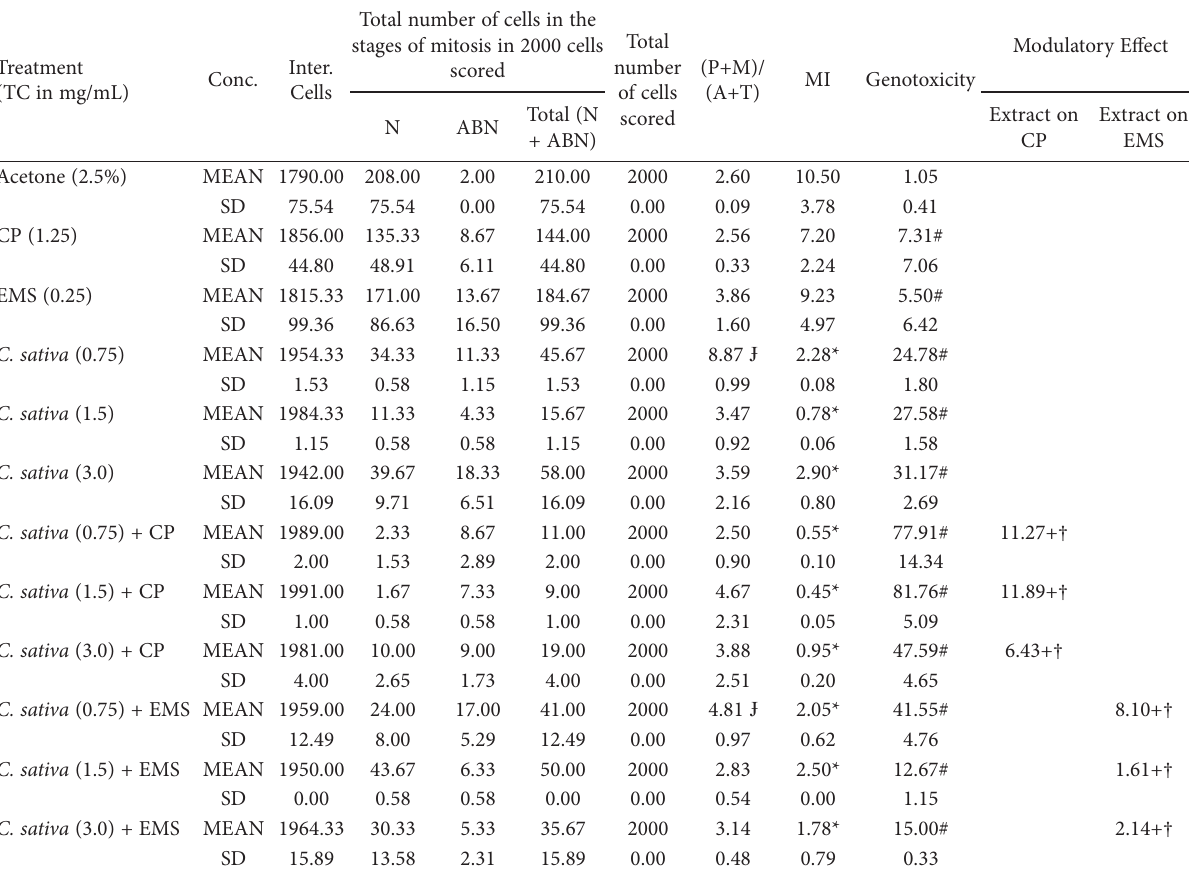
Table 3. Cytotoxic and genotoxic effects of methanol extracts of C. sativa , EMS and CP on meristem cells of onion root tip and the modula- tory effects (ME) of the methanol extract of C. sativa on EMS- or CP-induced genotoxicity.